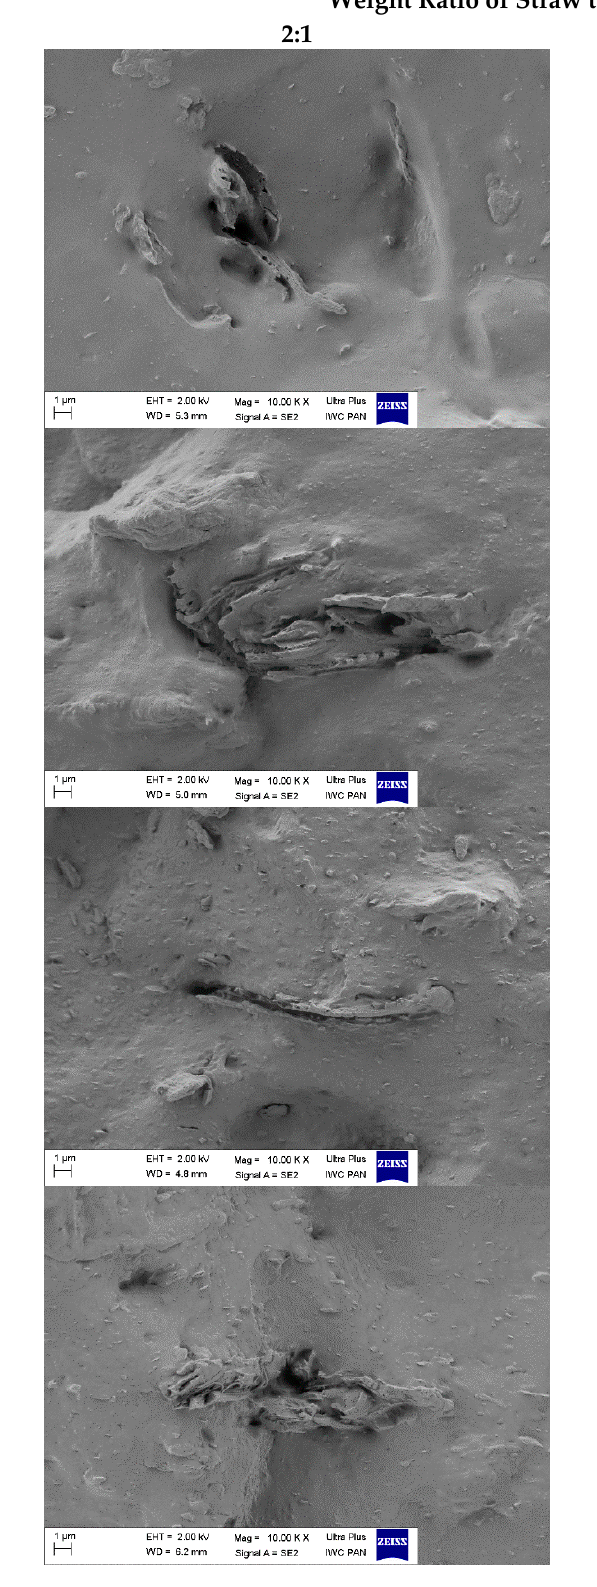
Figure 6. SEM images of biocomposites filled with 30 phr of straw-montmorillonite additives.